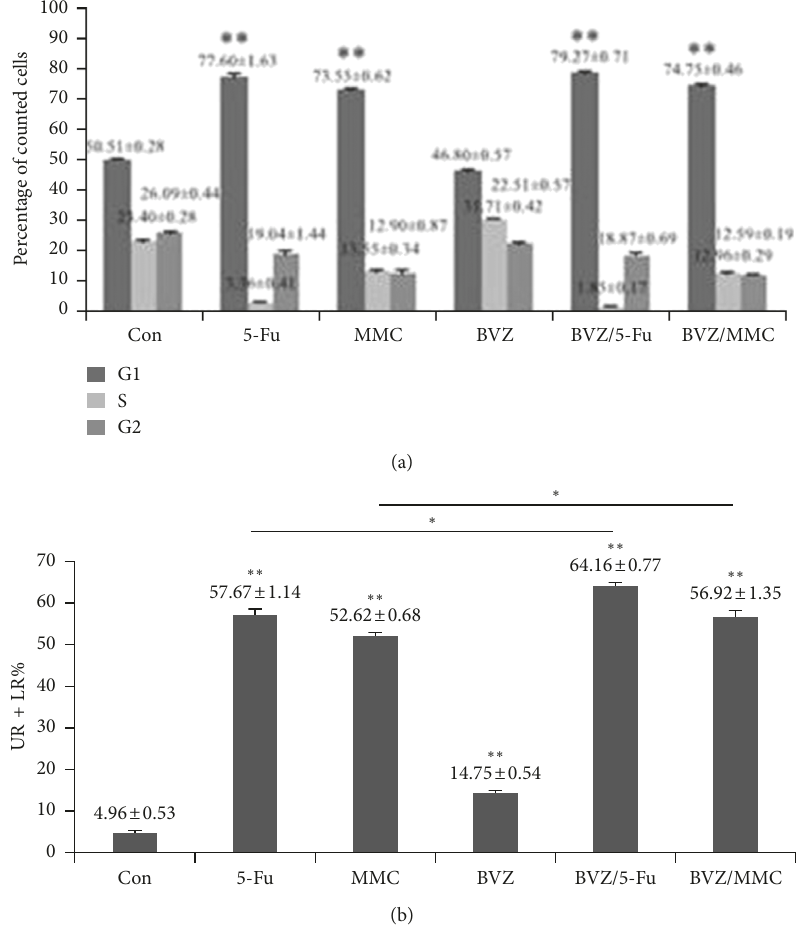
F IGURE 3: Analysis of the cell cycle and apoptosis of retinal pigment endothelium (RPE) cells. (a) Percentage of RPE cells in G1/G0, G2/M, and S phases after 48h of incubation in PBS control, 5mg/mL 5-fluorouracil (5-Fu), 0.02mg/mL mitomycin C (MMC), 2.5mg/mL bevacizumab (BVZ), 2.5mg/mL BVZ+5 mg/mL 5-Fu, and 2.5mg/mL BVZ +0.02 mg/mL MMC. cubation in the same concentrations of drugs on RPE cell